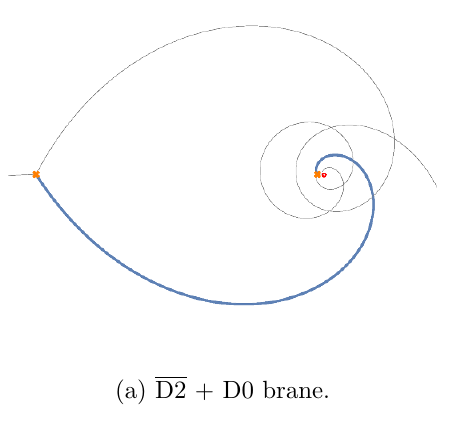
Figure 17. The two basic states for the conifold.